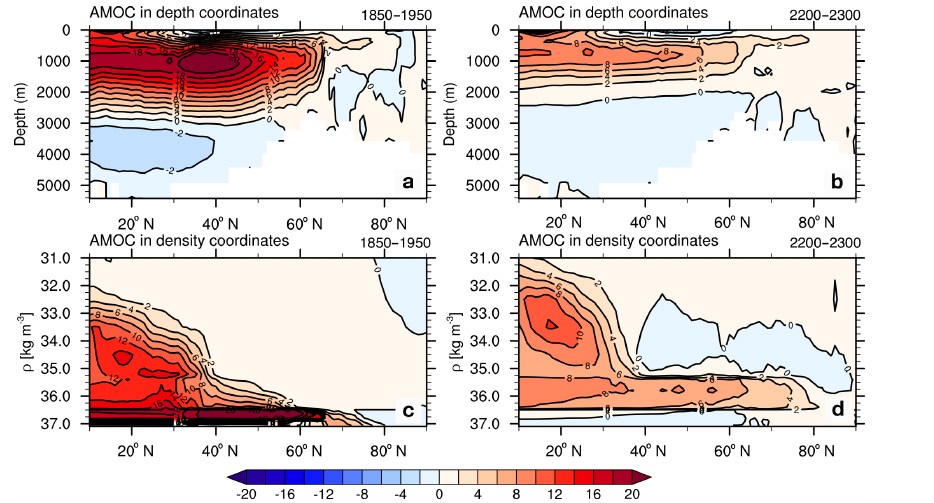
Figure 4. (a) and (b) show the AMOC in depth coordinates. (c) and (d) show the AMOC in density coordinates in the North Atlantic. (a) and (c) show the historical simulation (1850–1950) and (b) and (d) show RCP 8.5 (2200–2300). Contour interval is 2Sv.